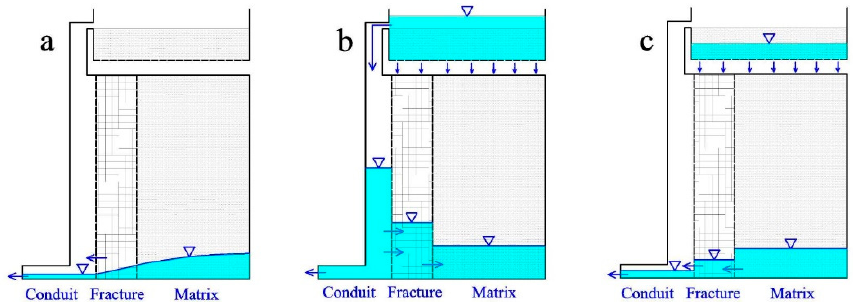
Figure 12. Stages of water charging and releasing process under short-time heavy rainfall condi- tion. ( a ). No rainfall for a long time; ( b ). Recharge in short-time heavy rain; ( c ). Recession after heavy rain.